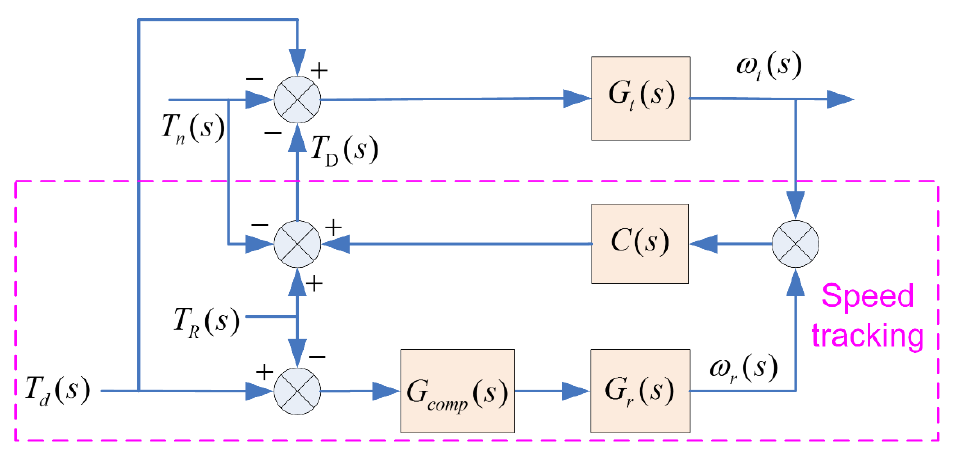
Figure 6. Control schematic diagram of speed tracking method.